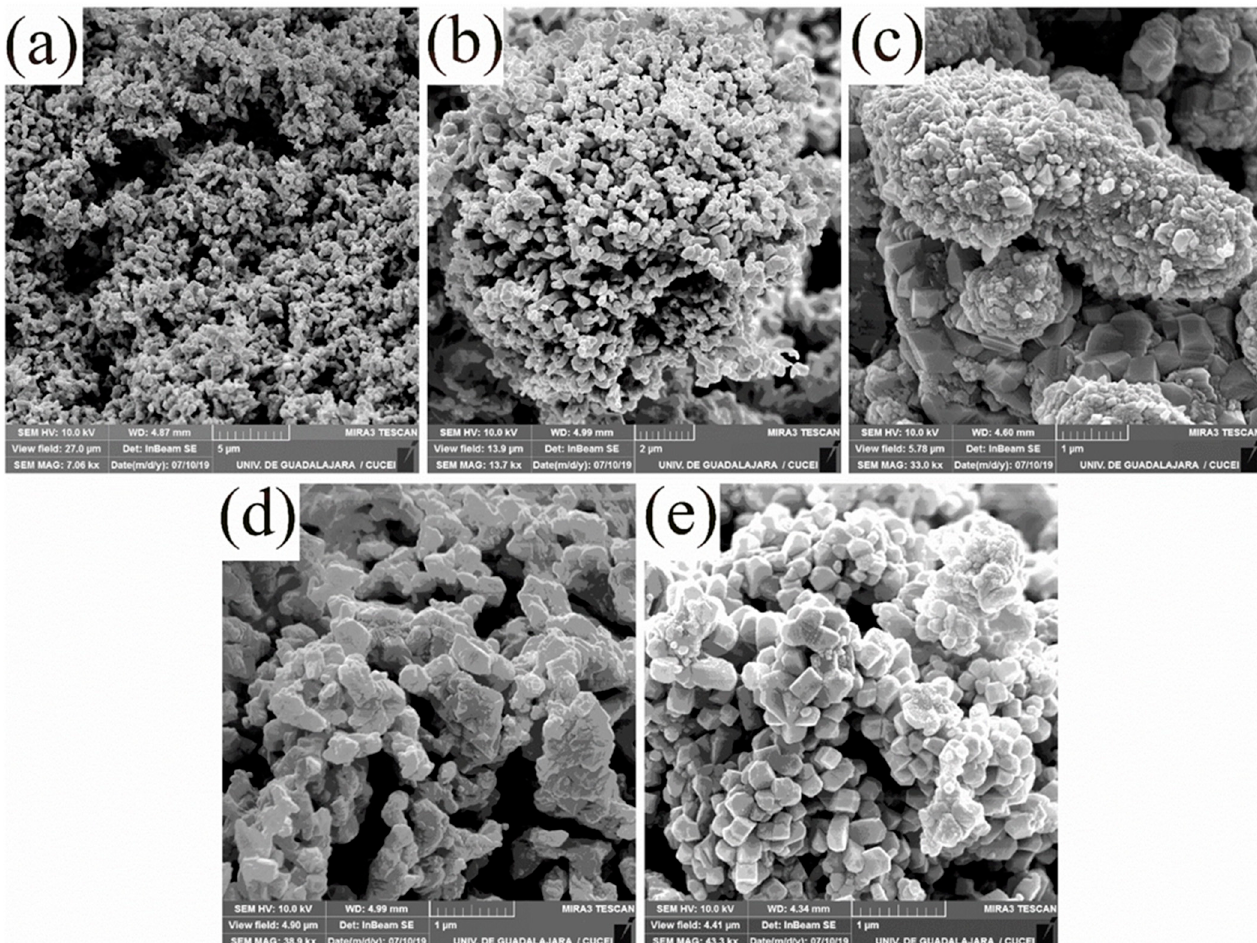
Figure 6. SEM images of NiSb 2 O 6 powders calcined at 900 ◦ C at the following magnifications: ( a ) 7.06 kx, ( b ) 13.7 kx, ( c ) 33.0 kx, ( d ) 39.9 kx, ( e ) 43.3